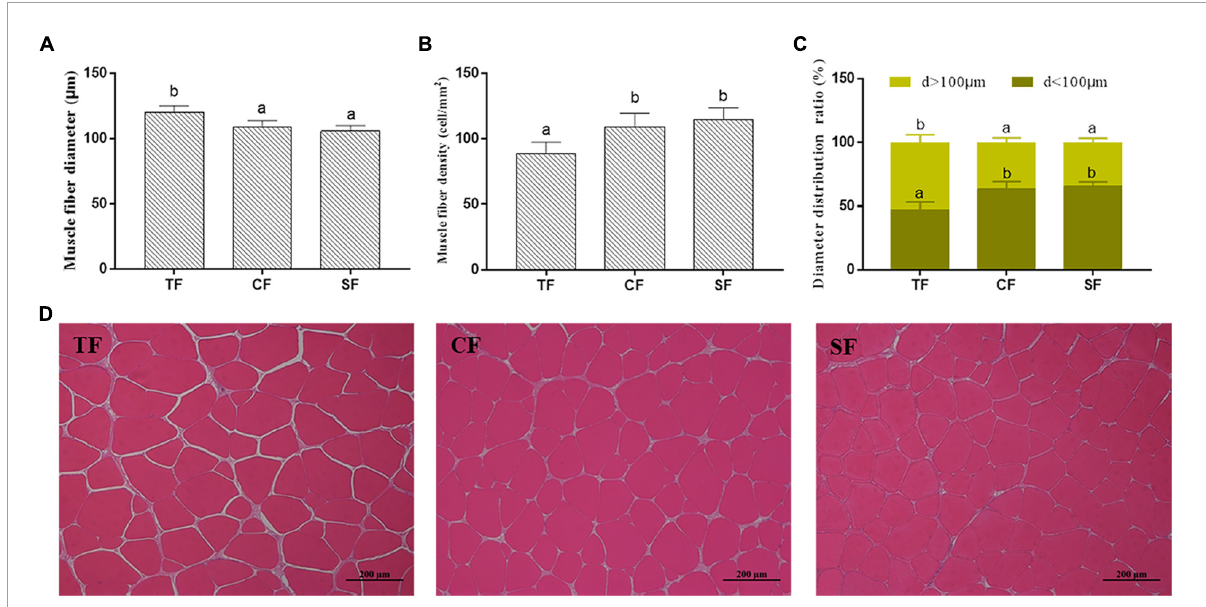
FIGURE1 The flesh structure of largemouth bass fed trash fish and formula feeds. Values are means ± SD ( n = 3) of three replicates. Bars with different letters denote significant difference among treatments ( P < 0.05). (A–C) Muscle fiber density (cell/mm 2 ), Muscle fiber diameter ( µ m) and Muscle fiber diameter distribution ratio (%), (D) Histological structure (100 × ).